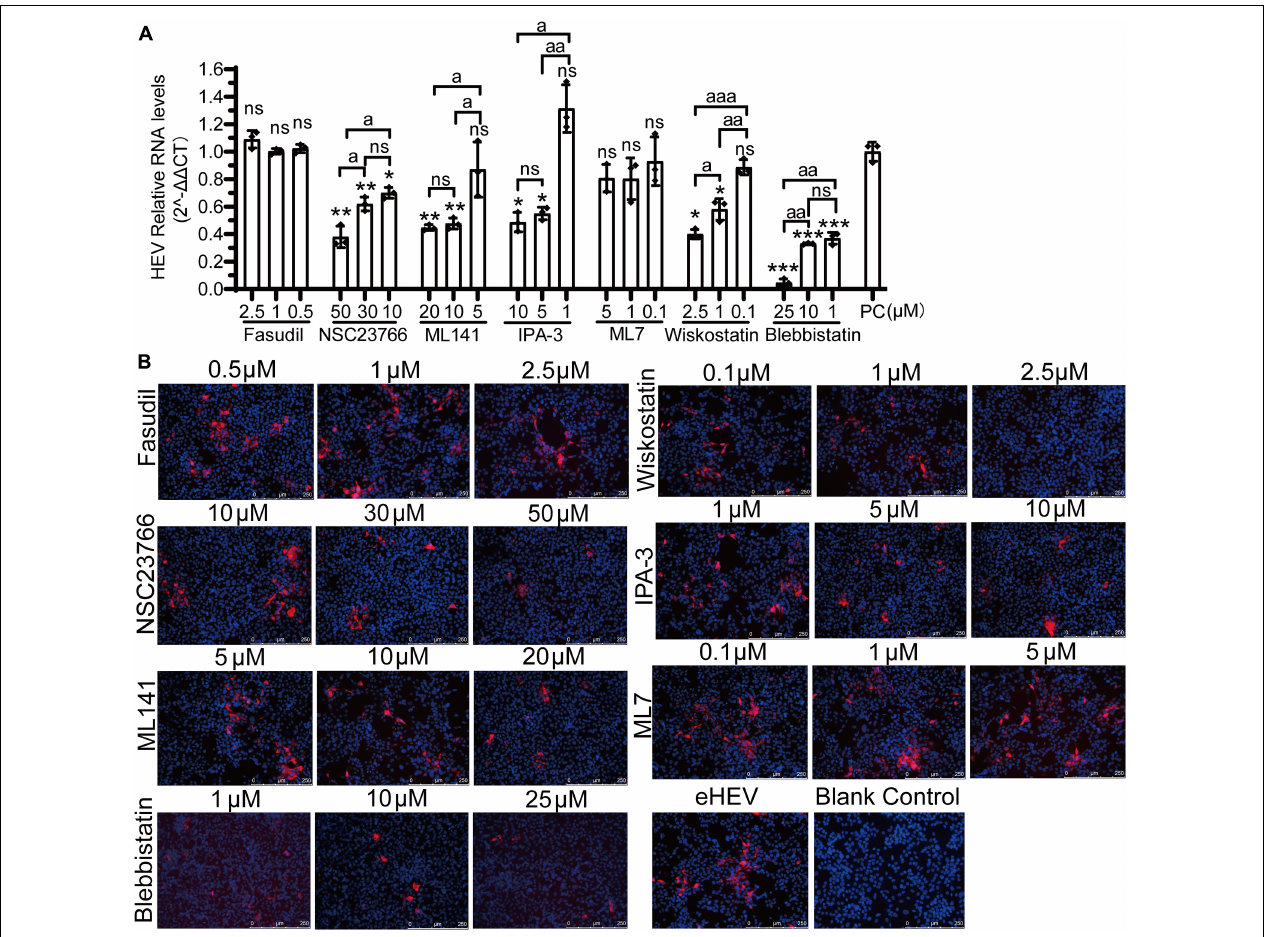
FIGURE 9 | CDC42/RAC1-PAK1 and CDC42/RAC1-(N-) WASP signaling pathways participate in quasi-enveloped HEV infection in HepG2/C3A cells. (A) There are relative mRNA levels of quasi-enveloped HEV-3 in HepG2/C3A cells treated with Fasudil, NSC23766, ML141, IPA-3, ML7, wiskostatin, and blebbistatin. The results were normalized with GAPDH mRNA in each group. (B) A detection of quasi-enveloped HEV-3 (designated eHEV) in HepG2/C3A cells at 5 dpi. Anti-HEV-ORF2 antibody (red) was used to detect the virus. Nuclei were counterstained with DAPI (blue). Scale bars, 250 µ m. ns, no significant; * and a, P < 0.05; ** and aa, P < 0.01; *** and aaa, P <